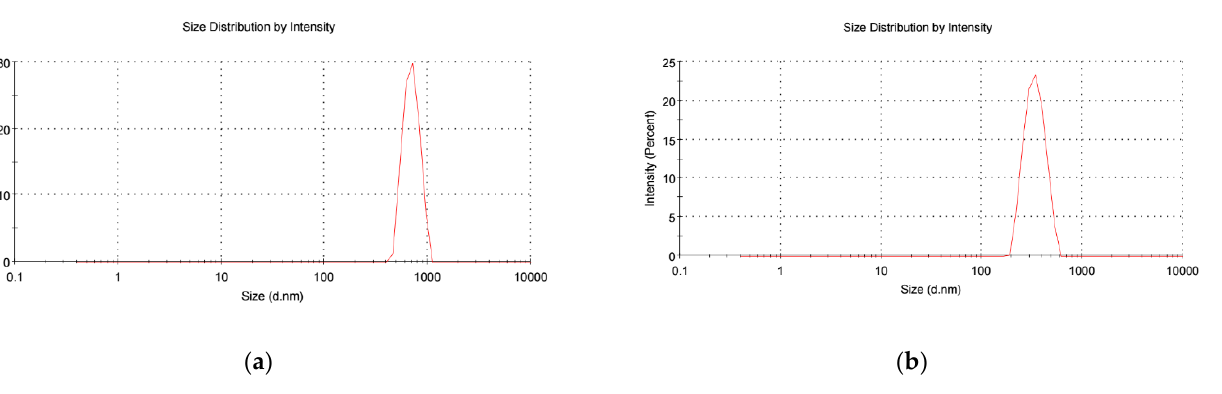
Figure 1. Size distribution tested by DLS measurements for PNP samples ( a ) before lyophilization and ( b ) after lyophilization. Samples were tested in triplicate. One representative result is shown for each group. The x-axes are presented on a logarithmic scale.